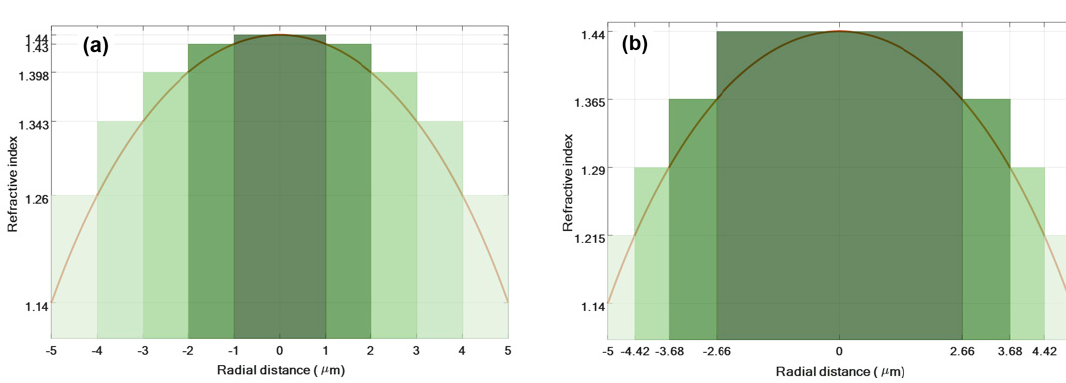
Figure 6. ( a ) Equilateral step (ELS) scheme of the refractive index profile with N = 5, where the step width = 1 μ m and R = 5 μ m. ( b ) Equi-index step (EIS) scheme with N = 4. The solid curve is the adapted gradient index profile for the effective index range of the designed BSW system, where the ∆ n max = 0.3 and n 0 = 1.141. Equivalent height stepping of the top layer will resemble the surface topologies shown